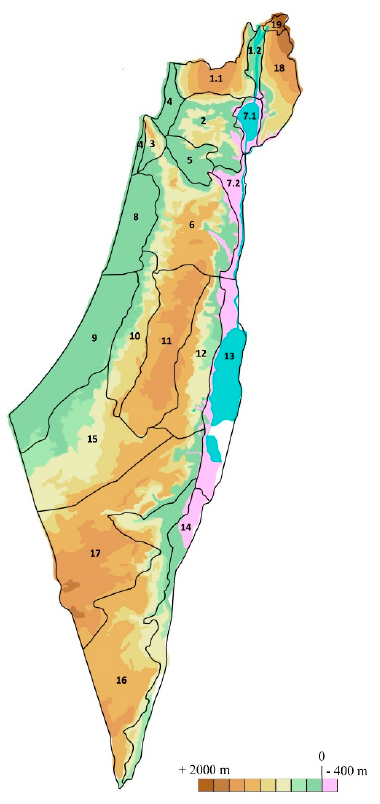
Figure 17. Zoogeographical map of Israel.